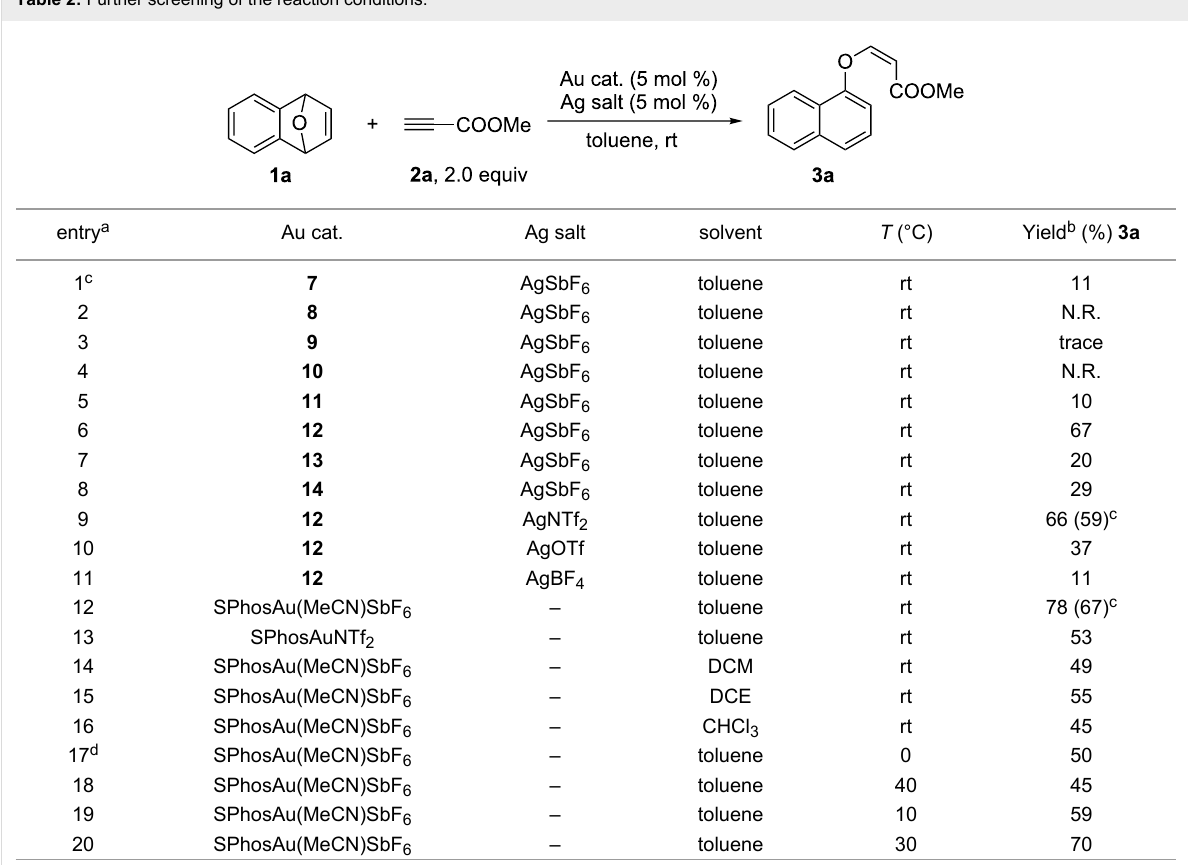
Table 2: Further screening of the reaction